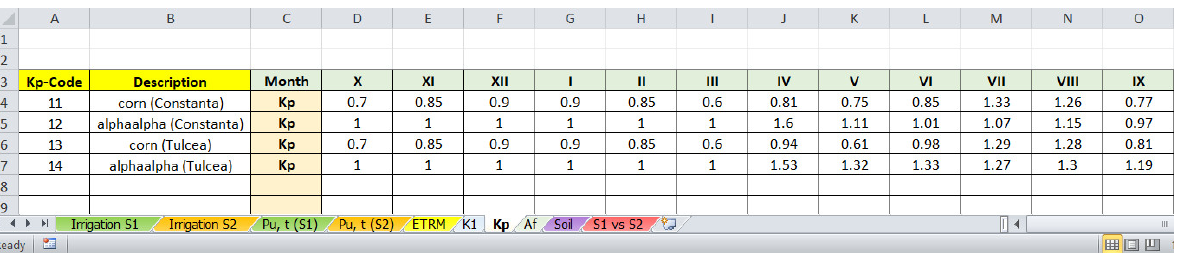
Figure 8. The “Kp” worksheet. Data are reproduced from [35], p. 41.